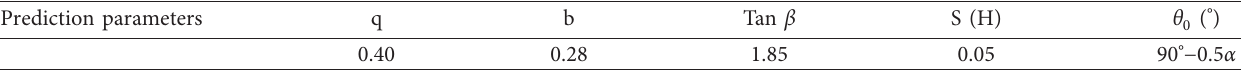
Table 5: Subsidence predicted parameters of the 15th coal seams’ strip mining. Prediction parameters